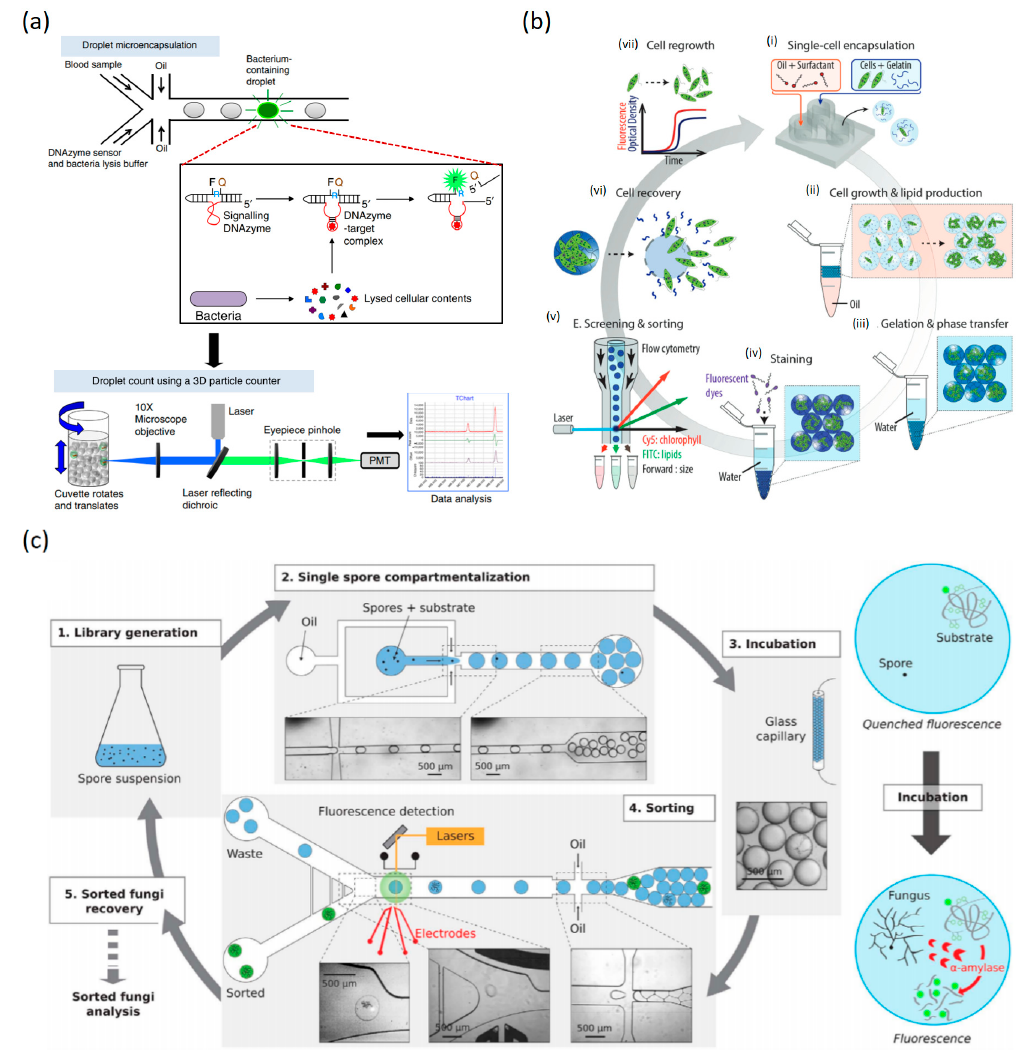
Figure 6. Digital-based microfluidics of cellomics. ( a ) Blood samples and DNAzyme sensors are mixed and then encapsulated in hundreds of millions of micrometer-sized droplets. DNAzyme sensors produce an instantaneous signal in the droplets that contain the bacterium, reproduced with permission from [113], published by Nature, 2014. ( b ) Encapsulation of single microalgal cells within monodisperse gelatin microgel compartments using microfluidic techniques, reproduced with permission from [124], published by John Wiley and Sons, 2018. ( c ) Droplet-based microfluidics screening platform. The screening platform for Aspergillus niger was composed of two distinct microfluidic devices, the first one for compartmentalization of spores and the second for sorting them, reproduced with permission from [133], published by Scientific Reports,